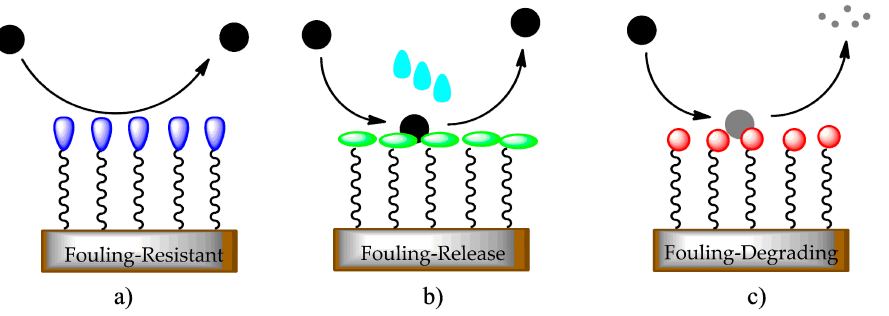
Figure 1. Schematic representation of the three major antifouling approaches: ( a ) limiting foulants from attaching to the covering (fouling-resistant), ( b ) minimizing foulant interaction with the surface (fouling-release), and ( c ) deteriorating/killing biofoulants (fouling-degrading).